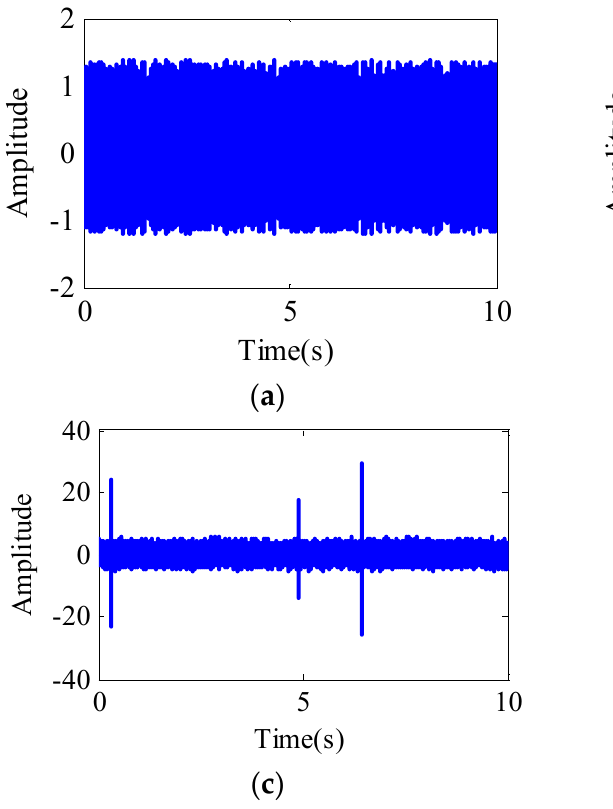
Figure 6. Simulation signal: ( a ) outer circle fault signal; ( b ) high-amplitude impulse interference caused by rail shortwave defects; ( c ) synthetic signal.